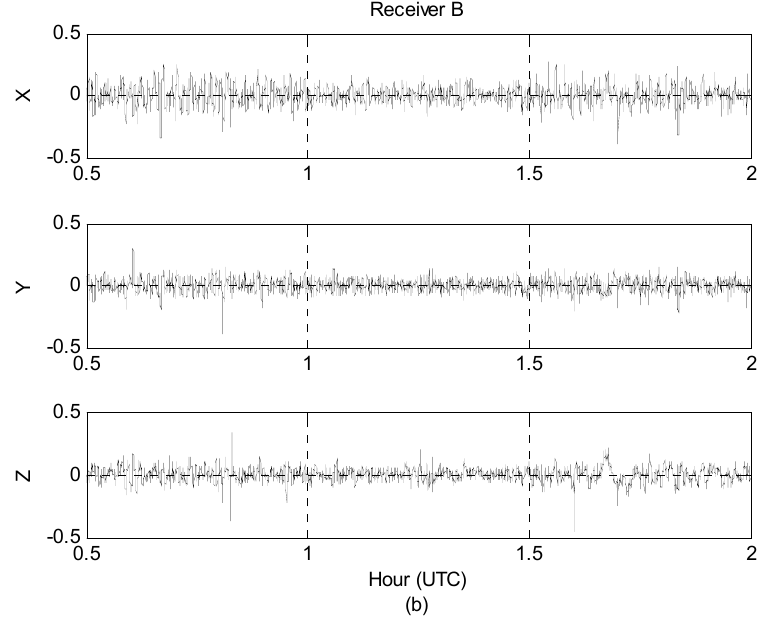
Figure 2. Estimated three-component kinematic accelerations in m/s 2 : ( a ) Receiver A; ( b ) Receiver B.